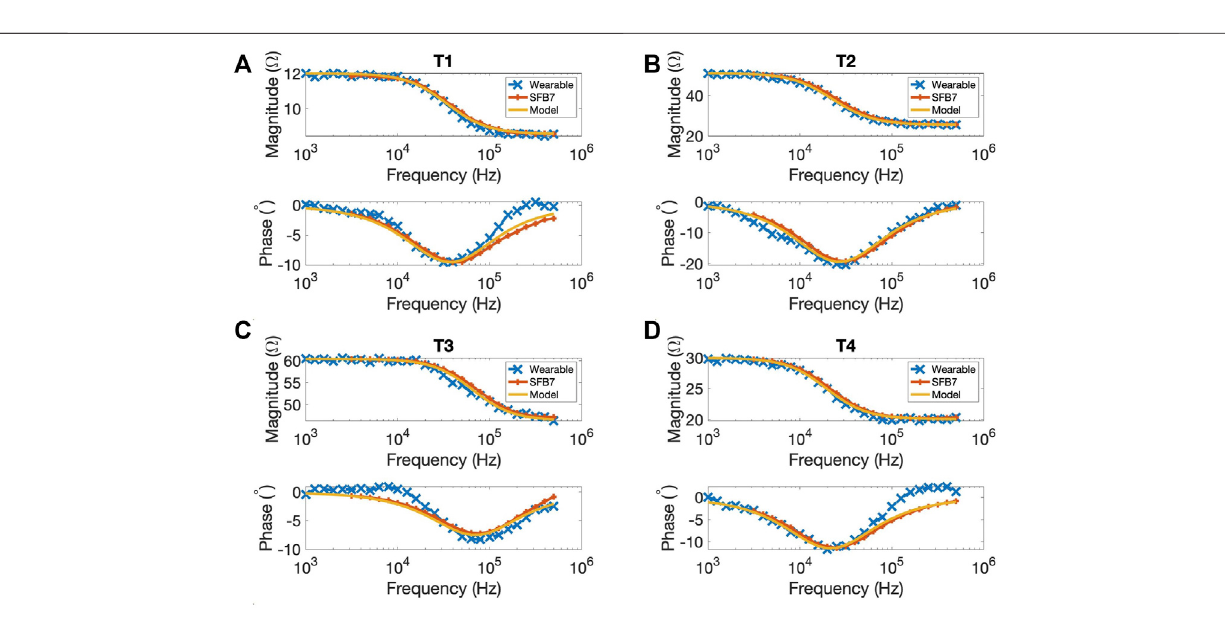
FIGURE7|(A – D) BodeplotresultsmeasuringthetestRRCPCBsT1throughT4usingboththewearableandSFB7.ValuesfortheRRCscanbefoundin Table1